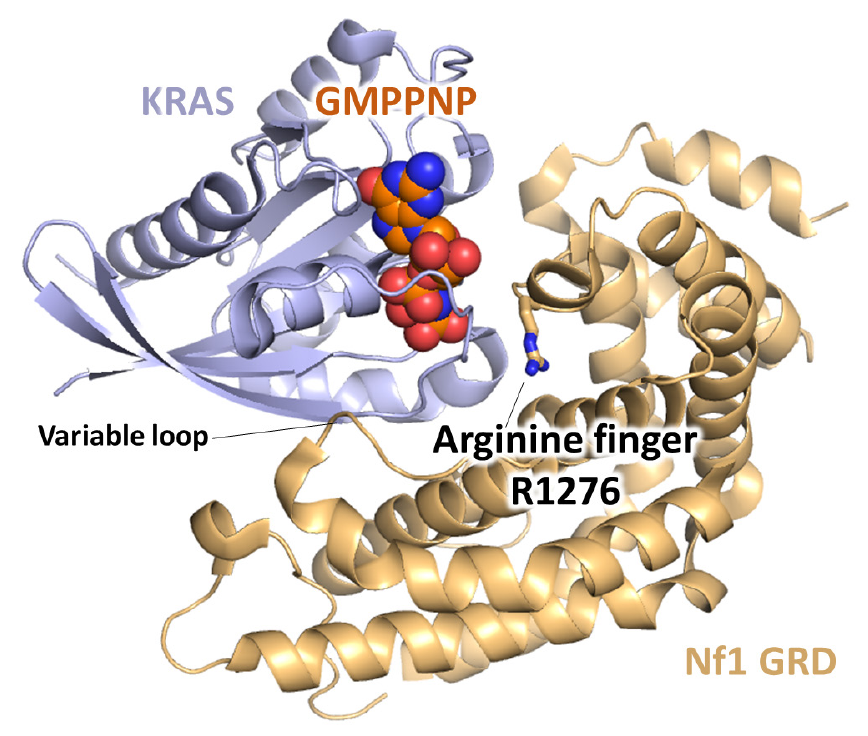
Figure 5. Structure of a KRas-neurofibromin GRD complex in a ribbon representation. The arginine finger (R1276) and variable loop are shown.